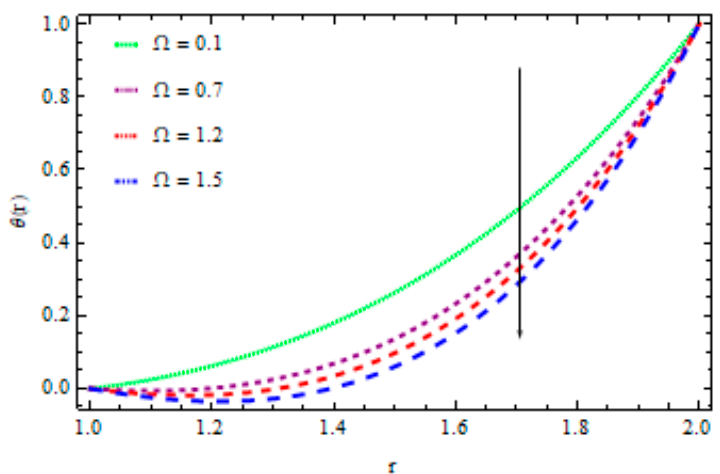
Ω on temperature distribution for Vogel’s model